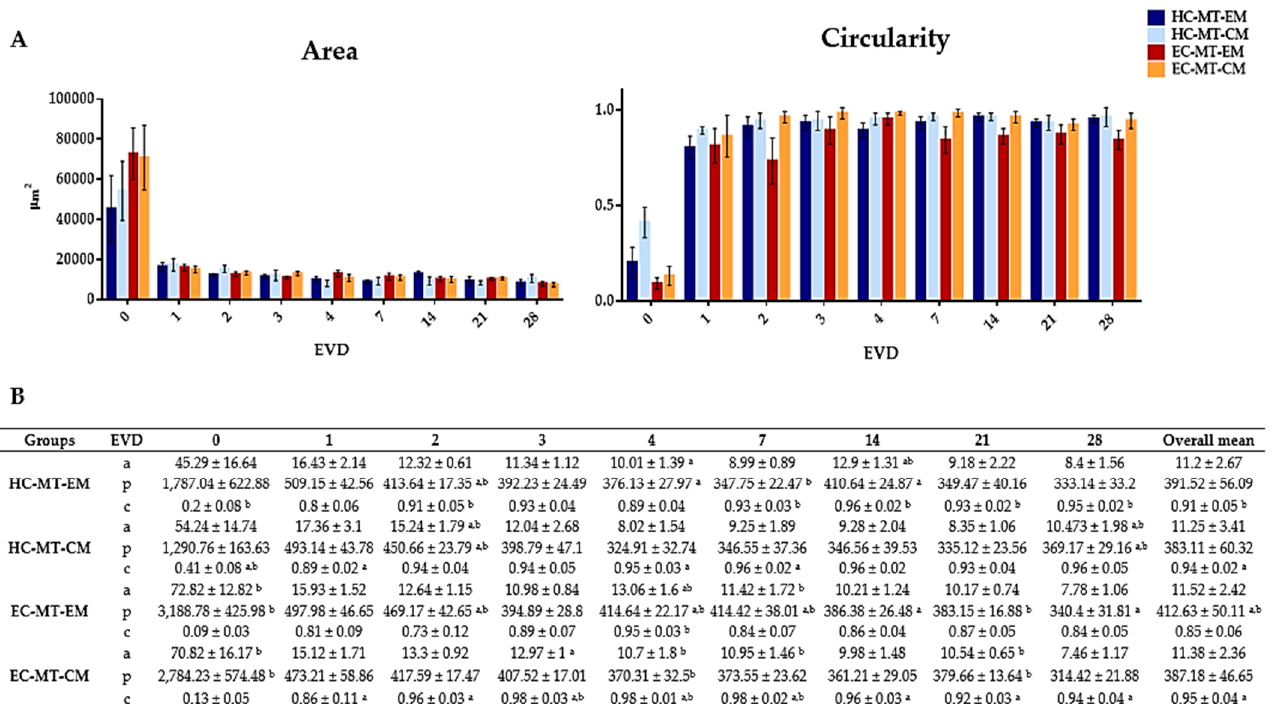
Figure 2. Graphical representation of Area and Circularity of human chondrogenic MTs for each day of EVD ( A ). Quantitative results of morphometric analysis of human chondrogenic MTs ( B ). Results are shown as mean ± SD values for area ( a ) ( µ m 2 × 103), perimeter ( p ) ( µ m 2 ) and circularity ( c ) for each experimental group and days of EVD. Here, p < 0.05 was considered statistically significant for the Mann–Whitney non-parametric test. Significant differences are indicated as follows: a Differences between MTs (HC or EC) with EM and their respective cell source MT with CM. b Differences between HC-MTs with EM or CM and EC-MTs with the same culture